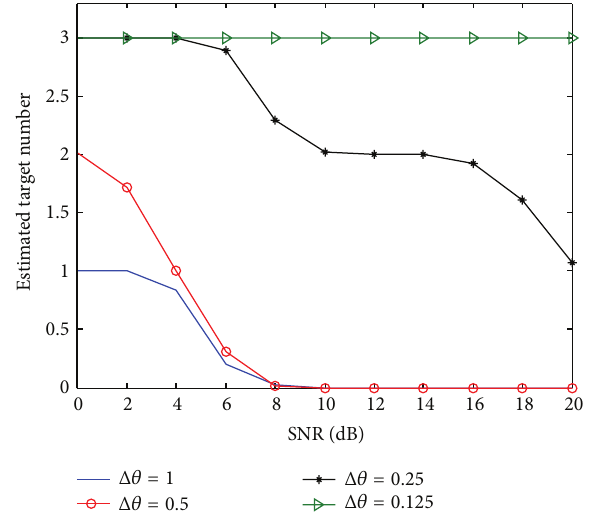
Figure 9: The number of estimated SOIs in case B, according to the size of the angle sample and the